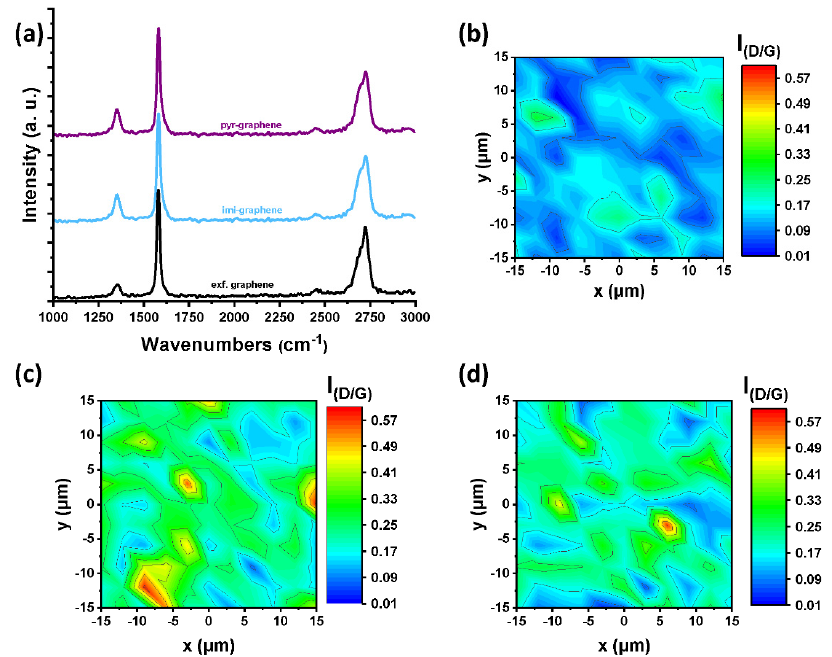
Figure A1. ( a ) Representative (average) Raman spectra (514 nm) of exfoliated graphene (black), pyr-graphene (purple) and imi-graphene (light blue). Spatial Raman spectra (514 nm, 30 × 30 µm area) of ( b ) exfoliated graphene, ( c ) pyr-graphene and ( d ) imi-graphene, depicting the D/G intensity ratio.